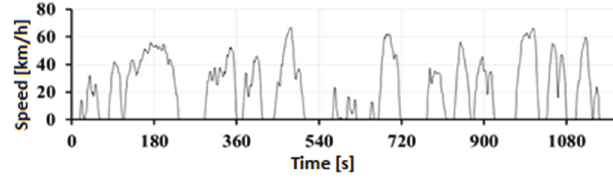
Fig. 4. Selected fragment of the speed course registered in road measure- ments